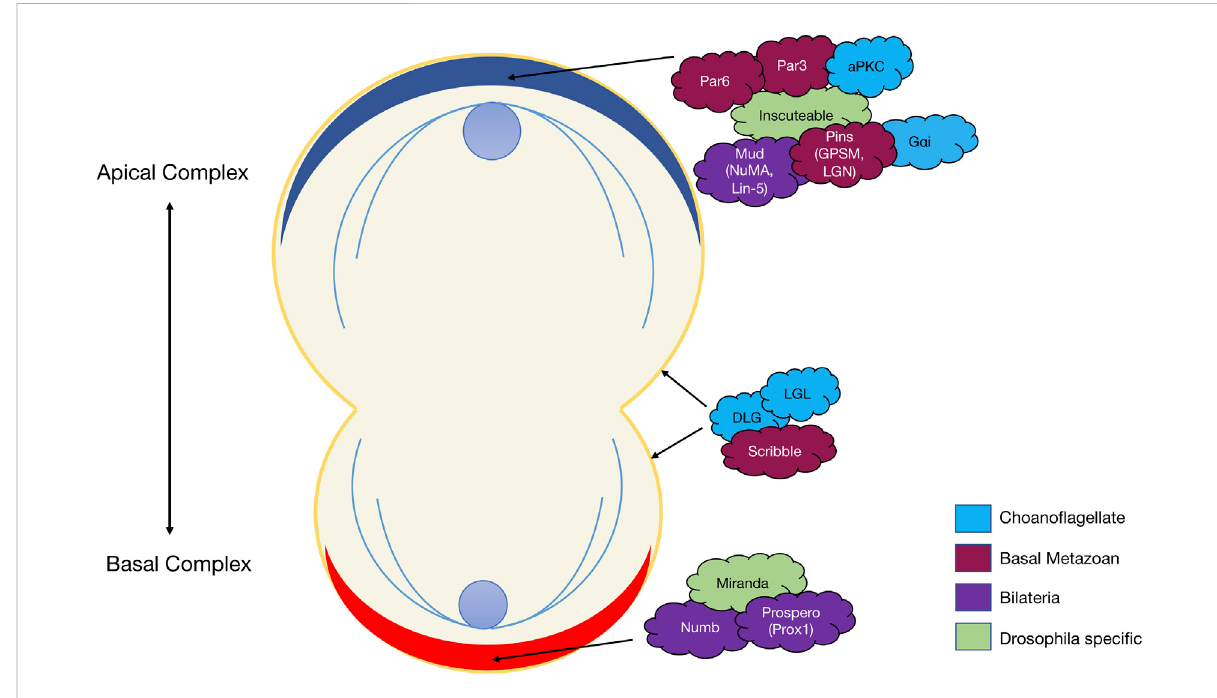
FIGURE 2 The diagram represents protein localisation in the Drosophila neuroblast as it undergoes asymmetric cell division. Colours represent the evolutionary appearance of these genes. Green proteins are Drosophila neuroblast ACD speci fi c.